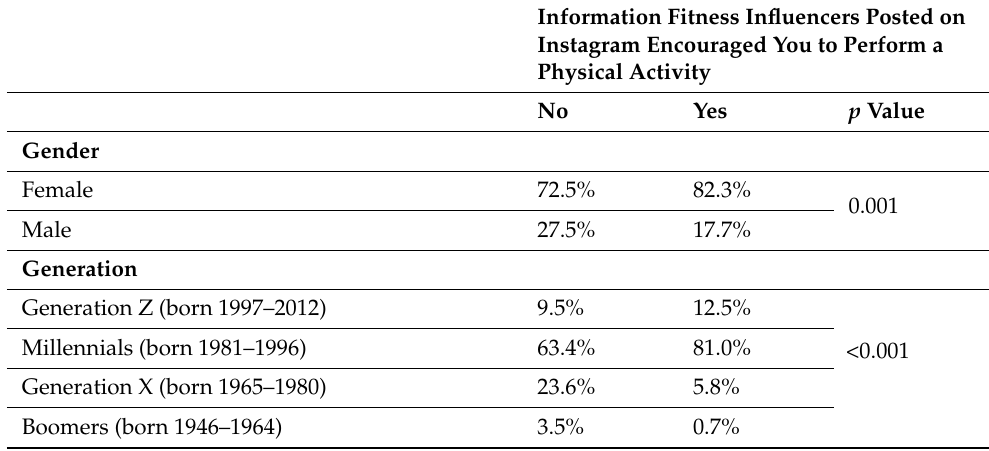
Table 3. Comparative analysis of the characteristics of the sample according to the variable “Has the information, fitness influencers posted, ever encouraged you to perform a physical